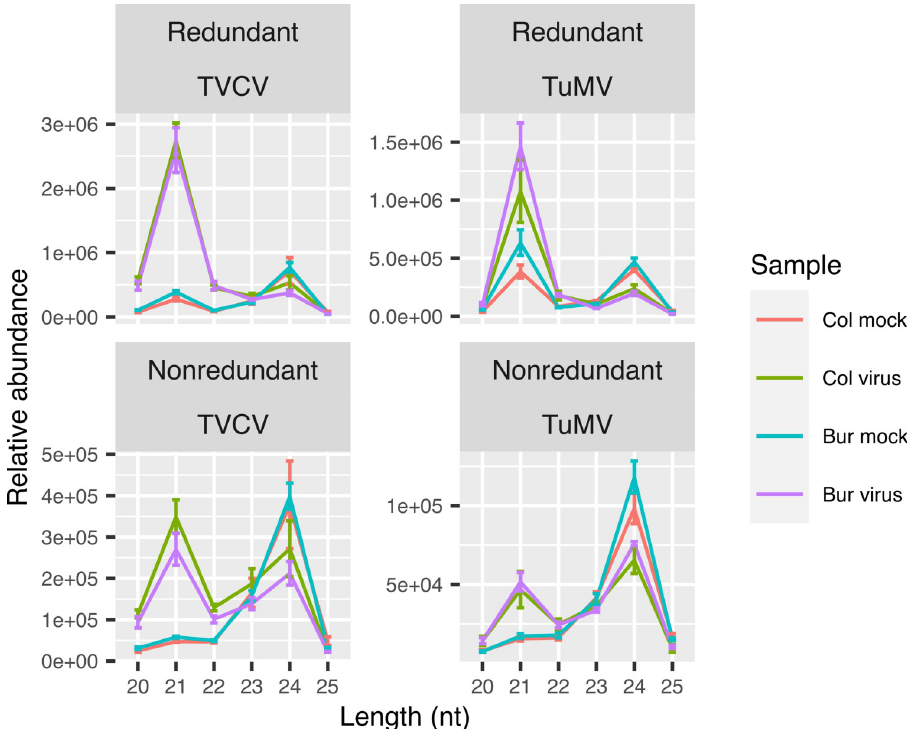
Fig 7. Sequence-length distribution of the host-derived sRNAs in Bur and Col plants infected either with TVCV or TuMV. The raw sRNA sequences were first adapter-trimmed, quality- and length-filtered, then rRNA and tRNA sequences were removed. The remaining sRNA sequences were mapped to the Arabidopsis thaliana TAIR10 reference genome with ShortStack. The raw abundances of the genome-mapped sequences were normalized with DESeq2. The normalization factors were used to scale the raw abundances of the size classes measured by FastQC. Error bars represent the standard error of the mean of four biological replicates.